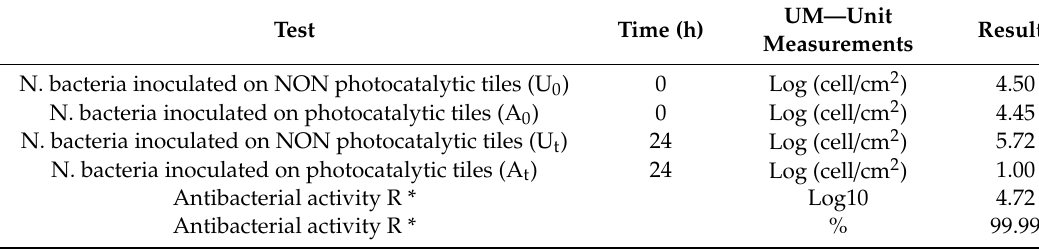
Table 2. Data and results of ISO 22196:2011